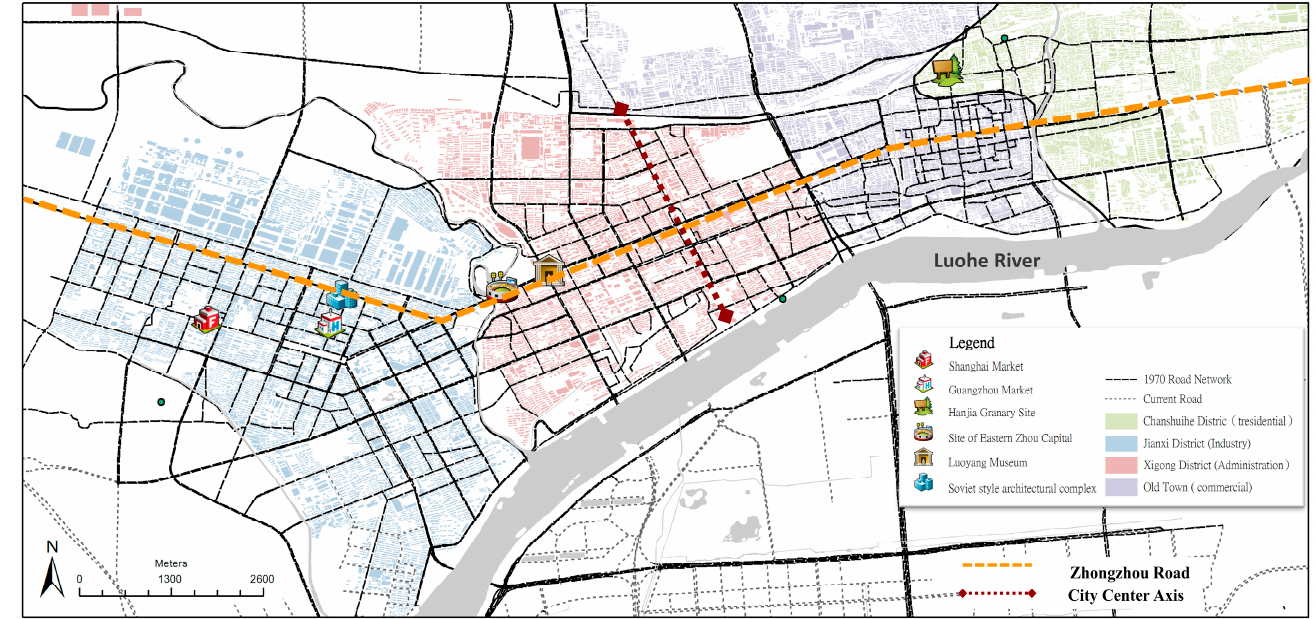
Figure 6. Historical translation map of the urban industrialization period. (Adapted according to historical maps of Luoyang and satellite pictures between 1969 and 1978.).